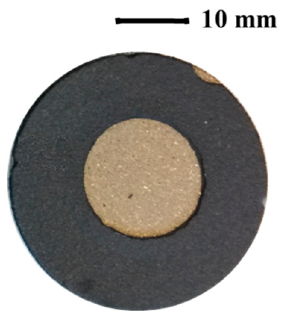
Figure 9. AT13-1 coatings after pull-off tests.